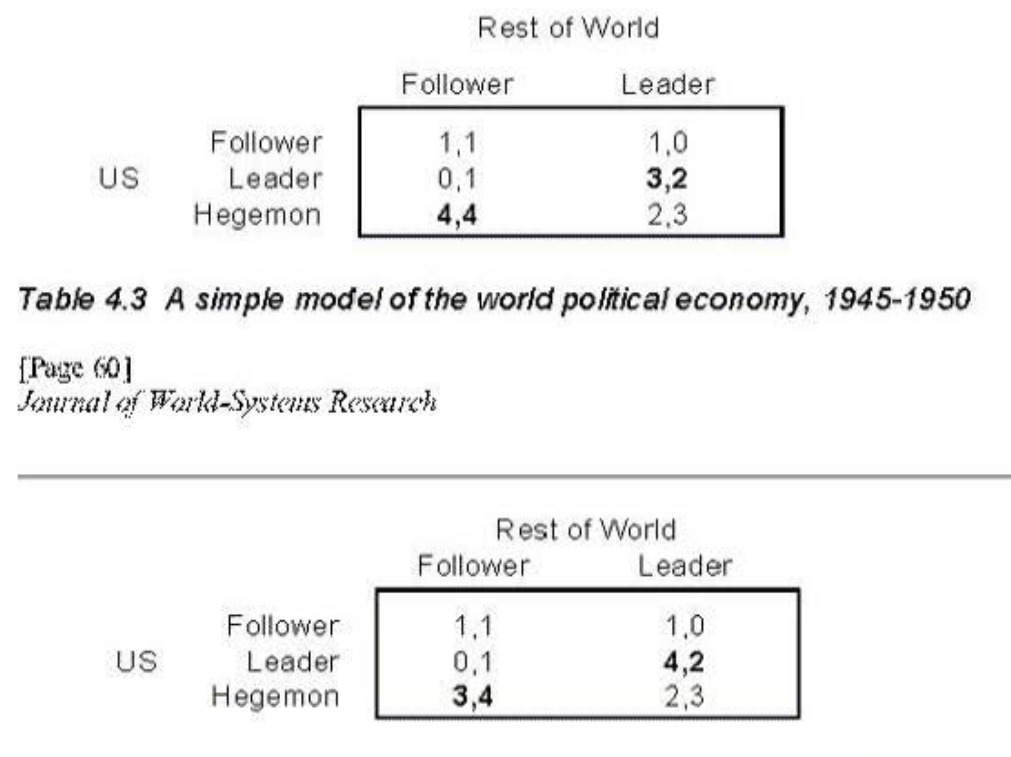
Table 4.4 A simple model of the world political economy,